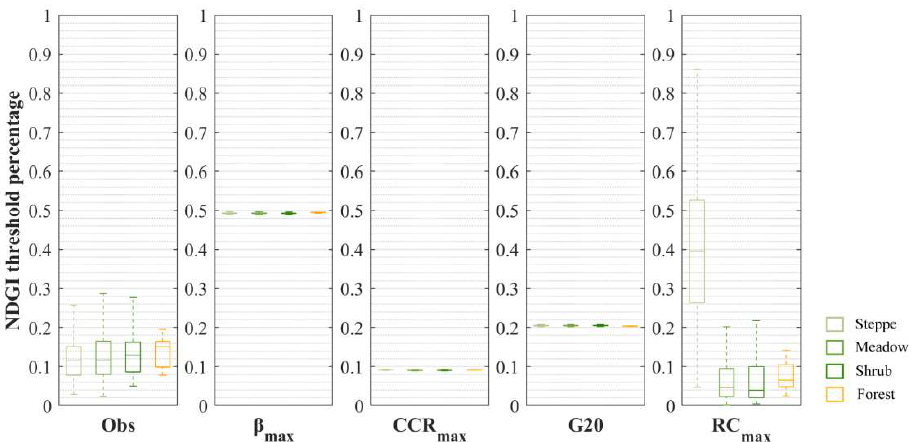
Figure 6. The threshold percentage of NDGI curve amplitude of GUDs extracted with the four methods in different vegetation types at the agrometeorological stations.